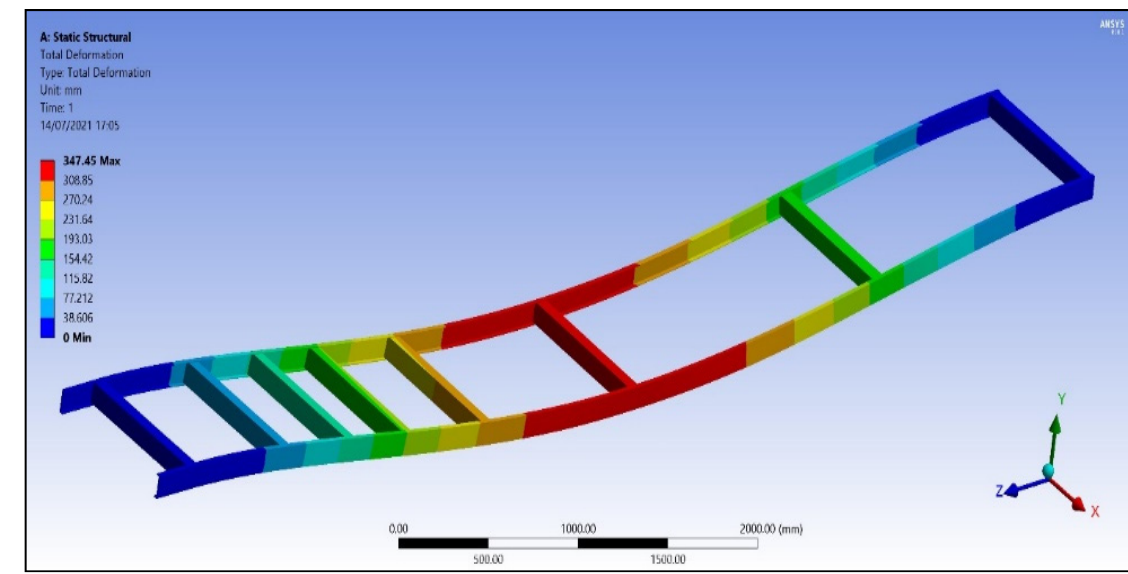
Figure 8. Deformation plot.